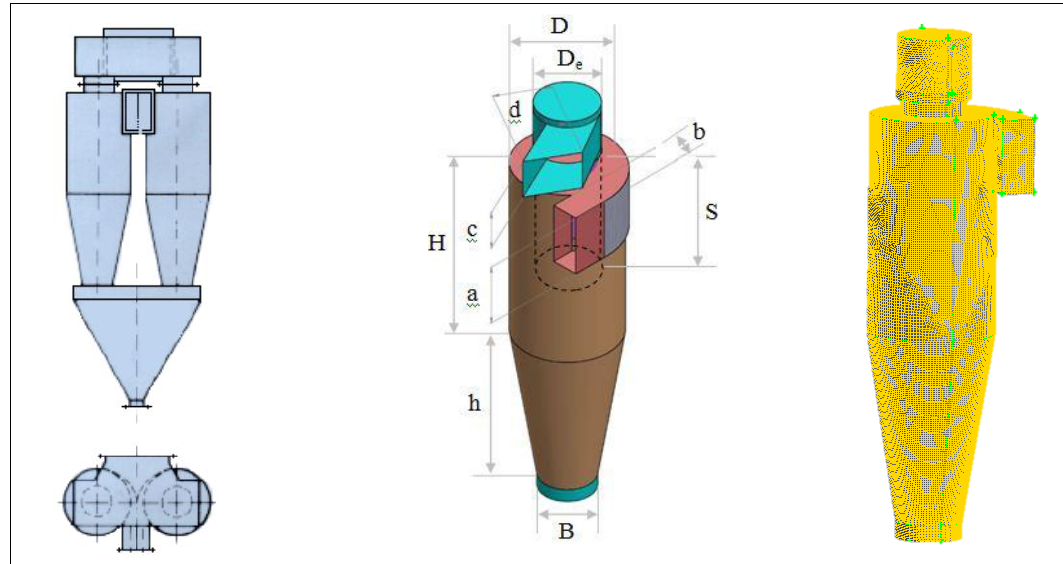
Figure 3. Industrial cyclone geometry and grid of